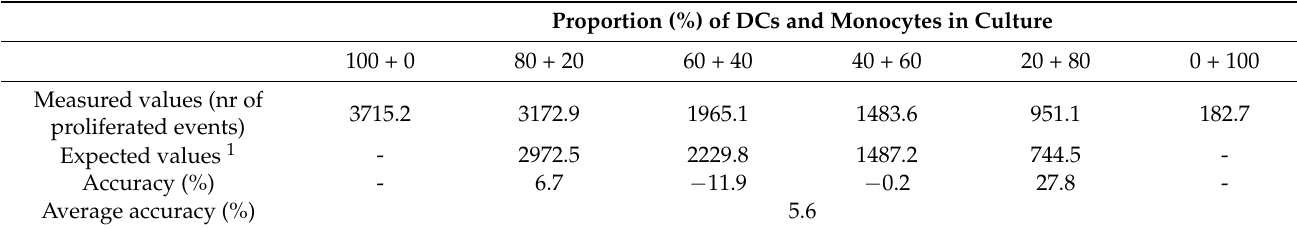
Table 1. Accuracy and relationship between expected and measured values.